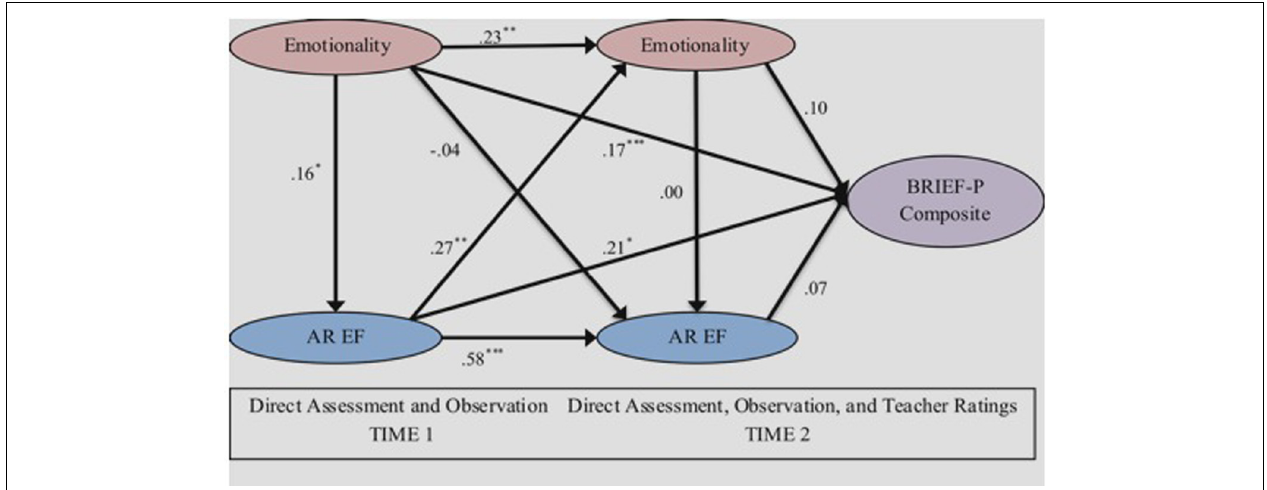
FIGURE 2 | Partial least-squares inner model. Note. Path coefficients may be interpreted as standardized beta coefficients. Levels of significance determined by t -values from bootstrapping procedures and may vary according to the standard error of the path coefficient; * p < 0.05, ** p < 0.01, *** p < 0.001.